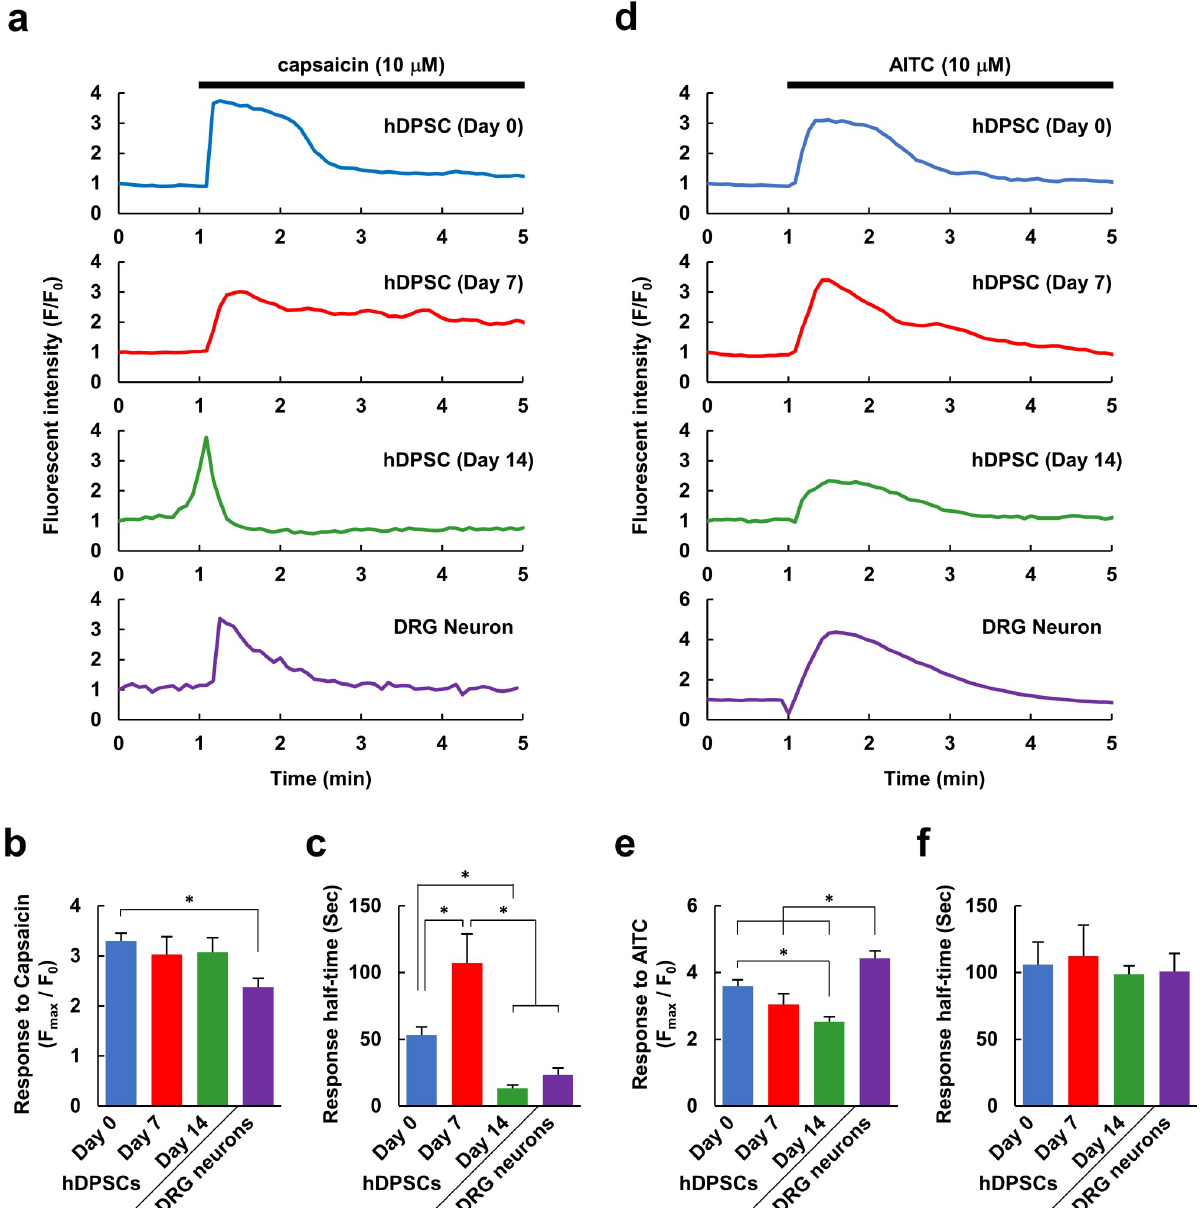
Fig 7. A transient receptor potential (TRP) channel agonist induces a Ca 2+ response in hDPSCs. (a) Representative Ca 2+ responses to capsaicin (10 μ M), an activator of TRPV1 channels, in undifferentiated (Day 0) and differentiated (Day 7 and Day 14) hDPSCs and in cultured DRG neurons. (b) Amplitude of responses to capsaicin application in hDPSCs differentiated for the indicated days and in cultured DRG neurons (n = 92, 19, 51, or 23 cells, respectively, from 2–4 different experiments). (c) Response half-time of capsaicin-induced Ca 2+ responses (n = 79, 16, 40, or 19 cells, respectively). (d) Representative Ca 2+ responses to allyl isothiocyanate (AITC, 10 μ M), an activator of TRPA1 channels, in hDPSCs differentiated for the indicated days and cultured DRG neurons. (e) Amplitude of responses to AITC application in hDPSCs differentiated for the indicated days and in cultured DRG neurons (n = 78, 13, 35, or 27 cells, respectively, from 2–4 different experiments). (f) Response half-time of AITC-induced Ca 2+ responses (n = 68, 13, 32, or 25 cells, respectively). Error bars, standard error of the mean. � P < 0.05 in a comparison of all combinations in each